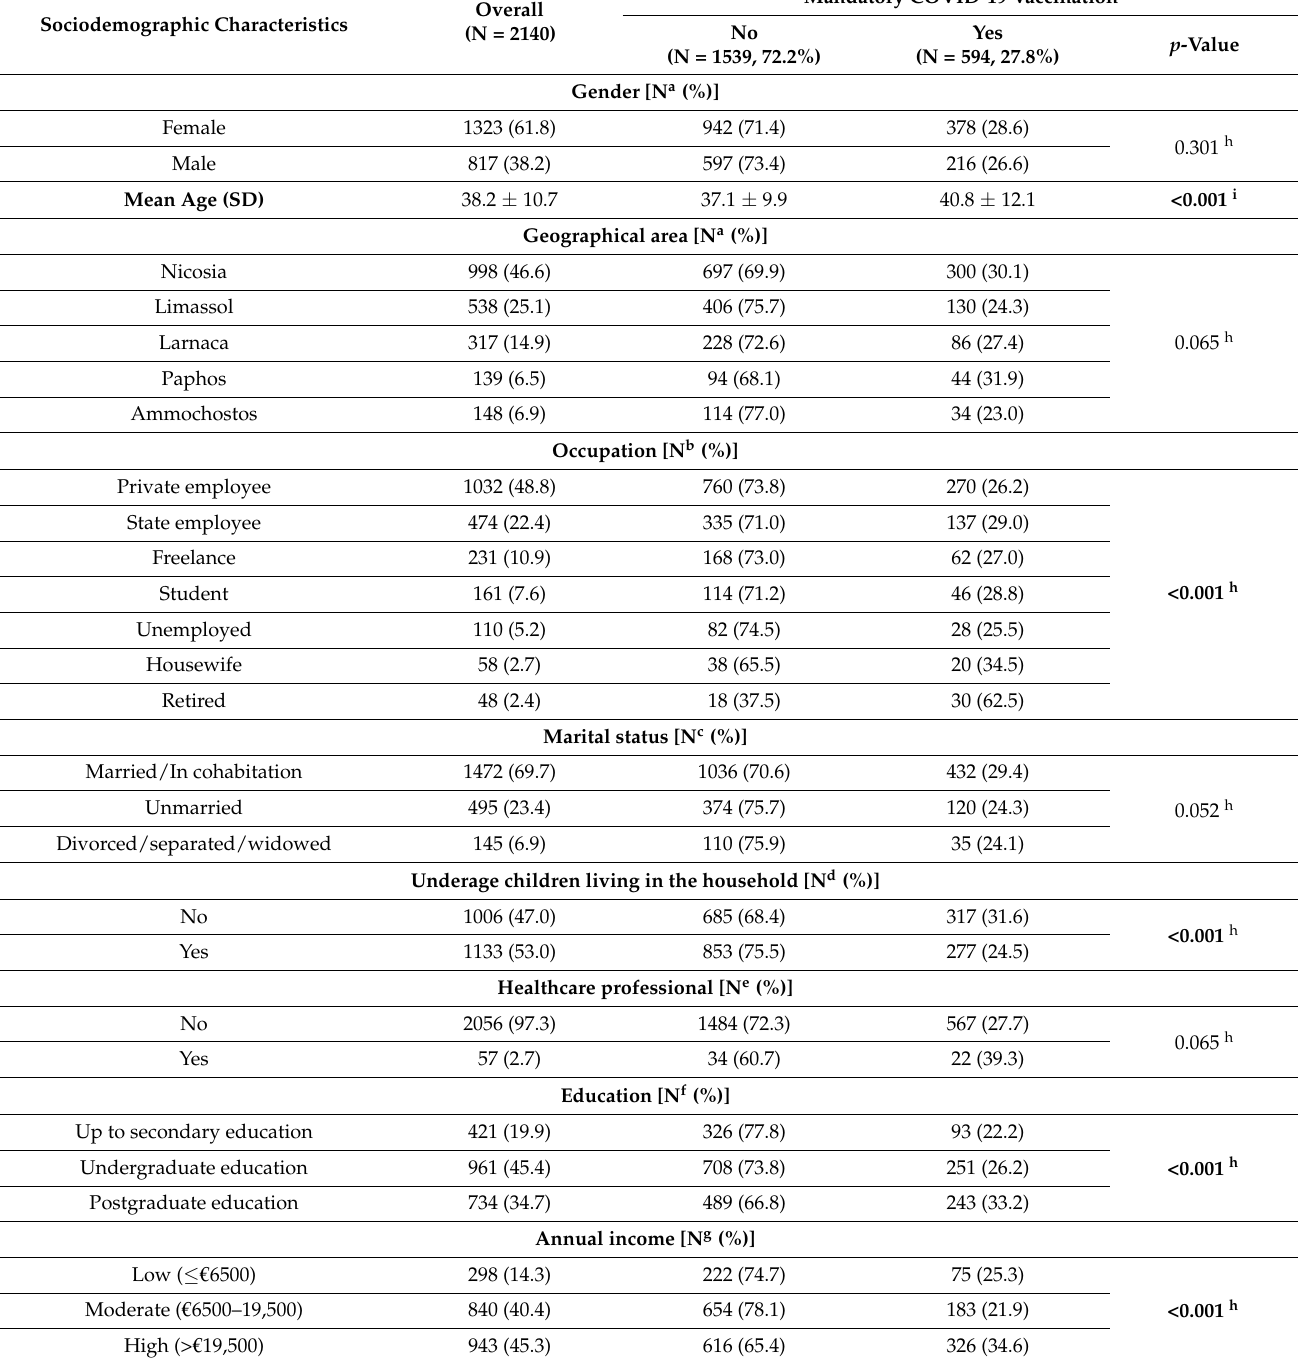
Table 1. Sociodemographic characteristics of all participants, overall and by mandatory vaccina- tion